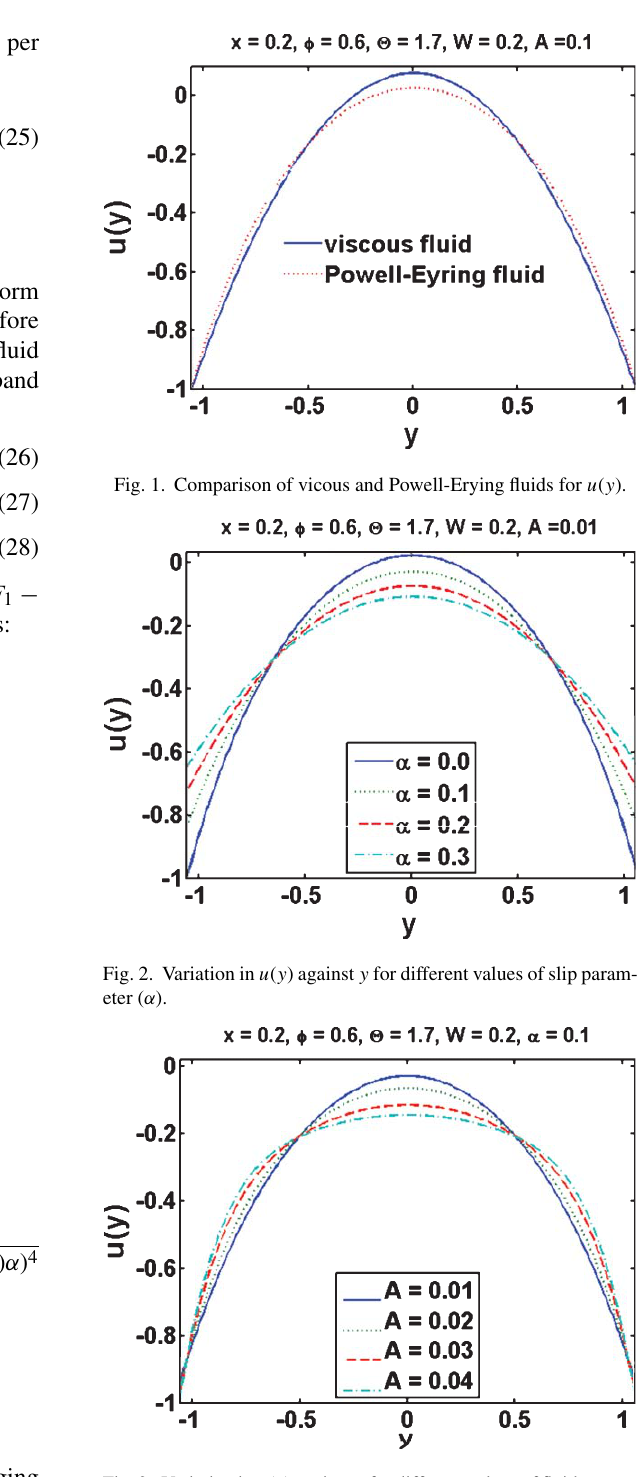
Fig.3. Variationin u ( y )against y fordifferentvaluesoffluidparam- eter ( A